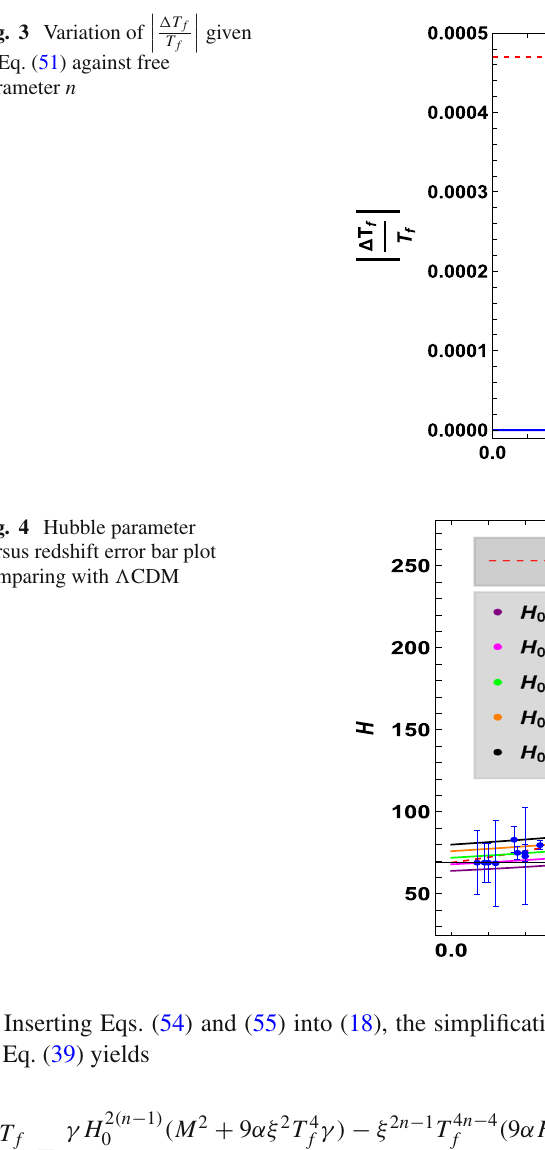
Fig. 3 Variation of in Eq. (51) against free parameter n